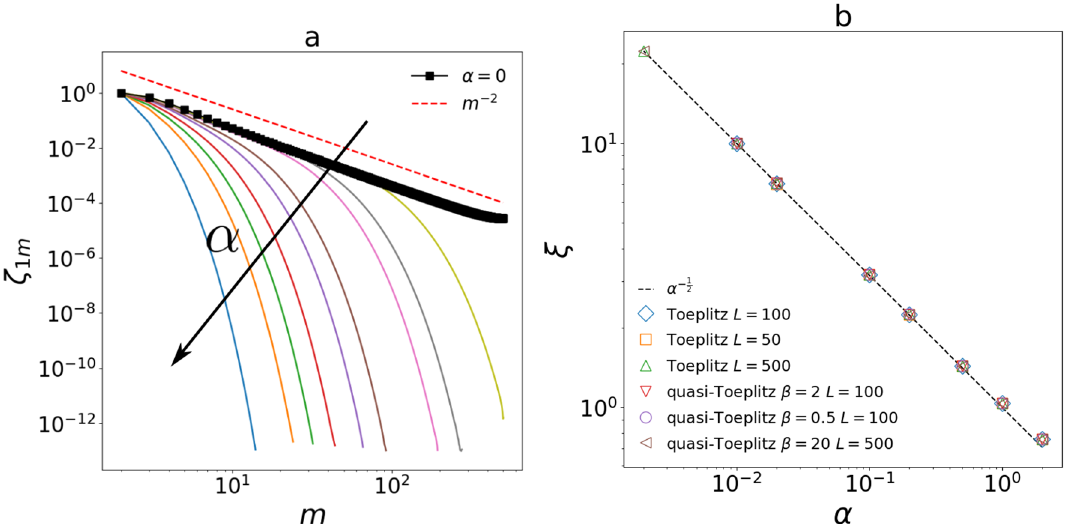
σ are obtained from Eq. (6) with ˆ 500 , γ 5 , β 1 α (i.e. Toeplitz = = = + 1 m α − 1 / 2 does not depend on the =